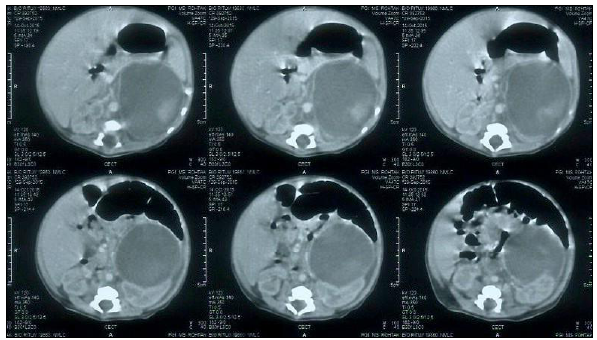
Figure 1: Computed Tomography abdomen of neonate showing large adrenal hemorrhage on left